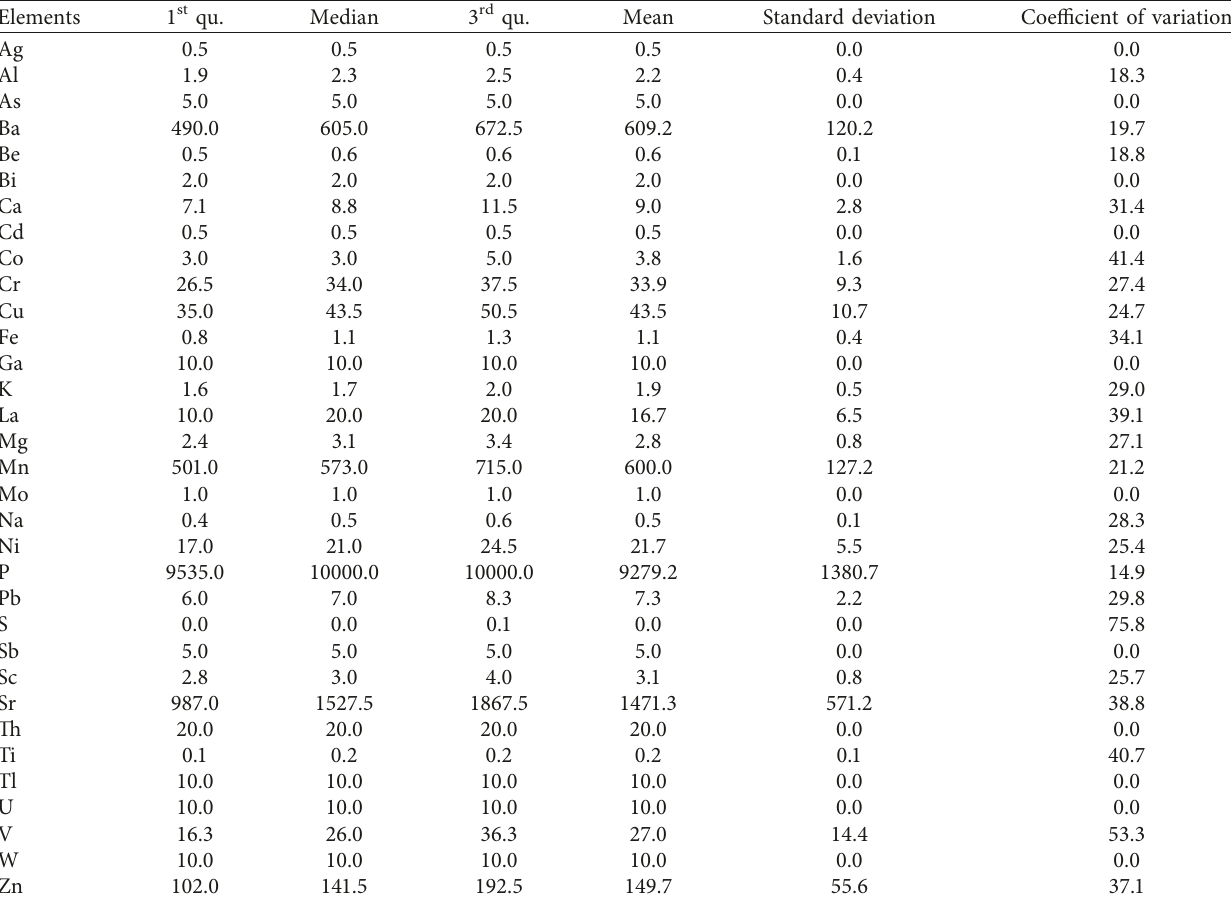
Table 2: Summary statistics for the concentration of different chemical elements within vitrified dung.